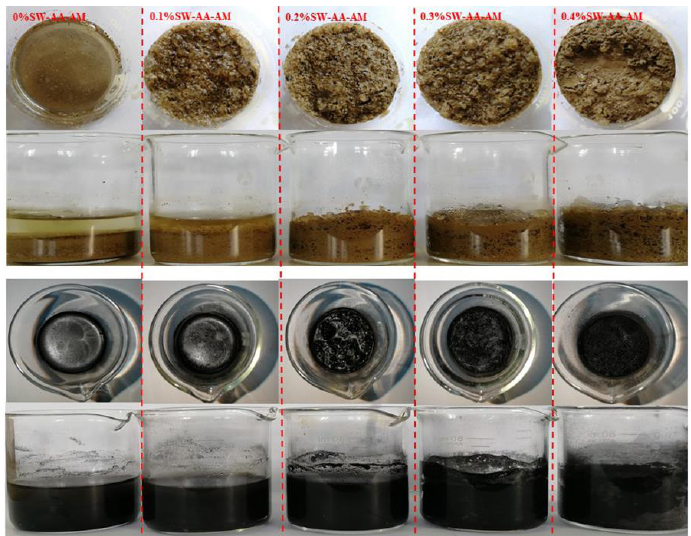
Figure 9. Water retention properties of SW-AA-AM polymer in soil and coal.